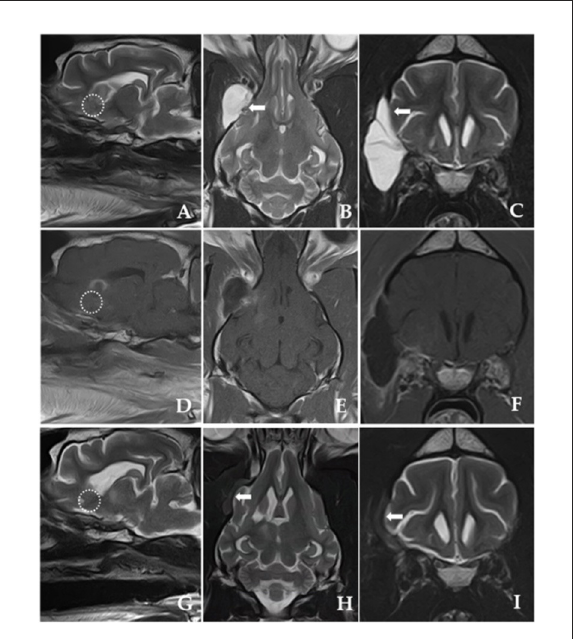
FIGURE4 Post-operative T2-weighted and post-contrast T1-weighted MRI images obtained 18 days after the surgery (A–F) . (G–I) Shown are post-operative T2-weighted MRI images 225 days after the surgery. (A,D,G) Shown are parasagittal images of complete resection of the tumor (dotted line) with well-managed peritumoural brain oedema after surgery. [ (B,C) ; white arrow] Marginal brain tissue herniation accompanying a fluid-filled lesion is discovered outside the right frontal lobe with a hyperintense signal presumably due to cerebrospinal fluid (CSF) leakage immediately after the surgery. T2-weighted MRI images obtained 225 days post-operatively [ (H,I) ; white arrow] show evidence of CSF leakage improvement, but the volume of brain tissue herniating through the dural defect remains and slightly